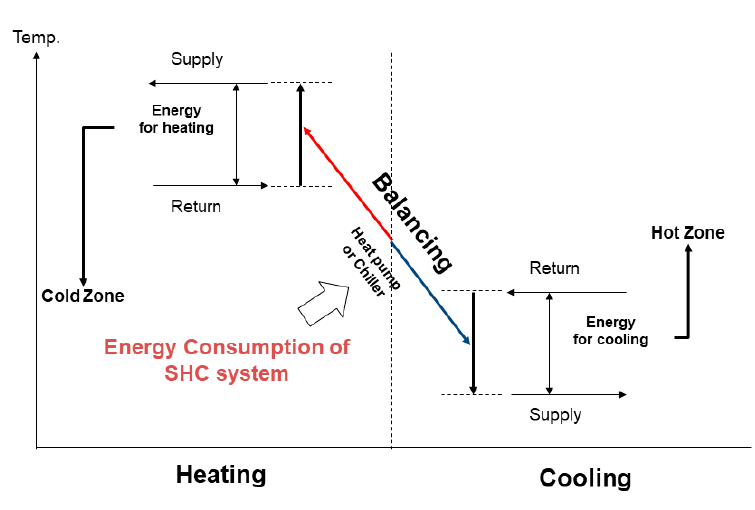
Figure 2. Concept diagrams of SHCs.